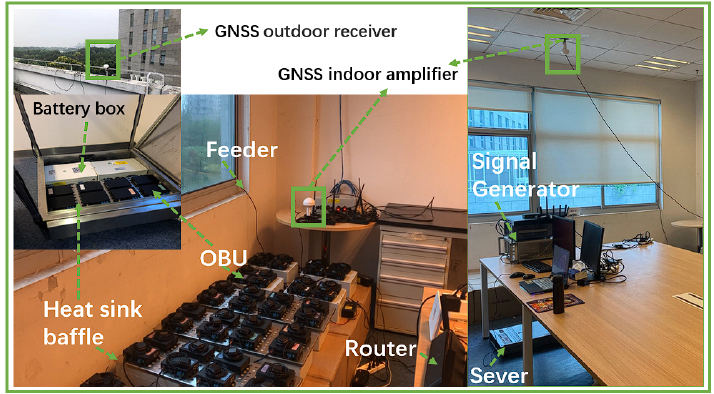
Figure 11. Indoor testing setup.